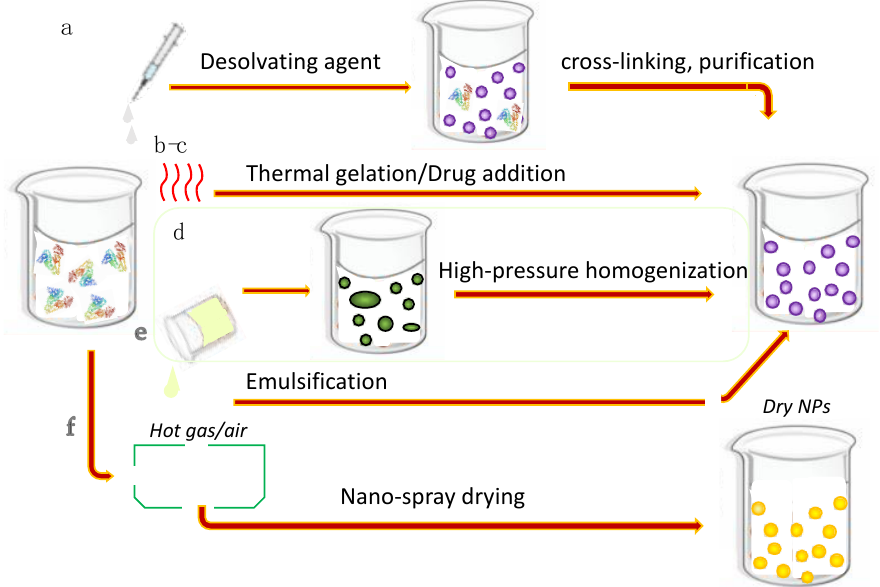
Figure 3. Schematic representation of the preparation methods for SANPs: ( a ) desolvation method, ( b ) thermal gelation, ( c ) self-assembly, ( d ) nab technology, ( e ) single emulsion method and ( f ) nanospray drying.